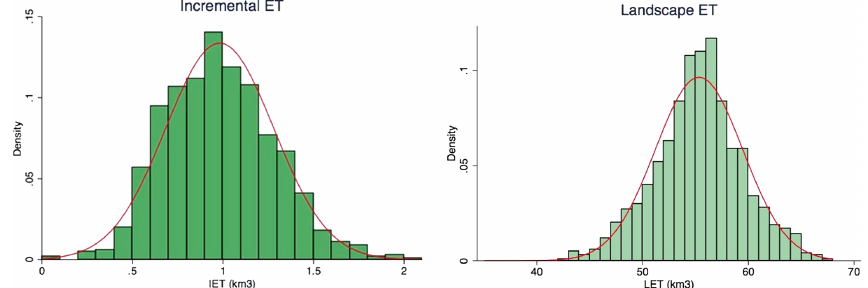
Figure 9. Variability of two selected output parameters for 2009, i.e., incremental ET and landscape ET, following from the Monte Carlo simulation of 1000